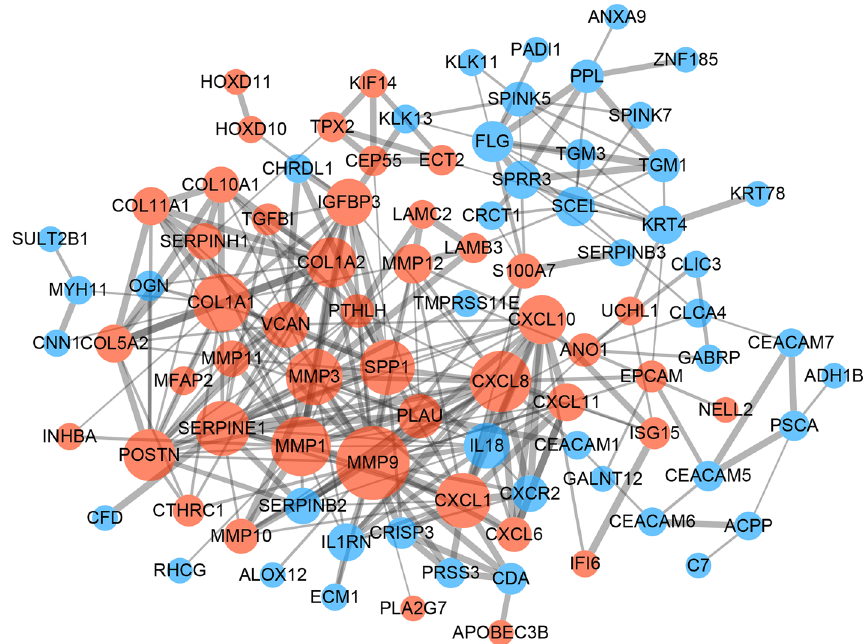
Figure 5. PPI network construction and hub gene identification. The PPI network consisted of 91 nodes and 304 edges. The red nodes indicate the upregulated genes, and the blue nodes indicate the downregulated DEGs. The node size represents the connectivity degree. The edge thickness represents the combined score. The network was visualized with Cytoscape software (Version 3.72, http:// www. cytos cape. org/).